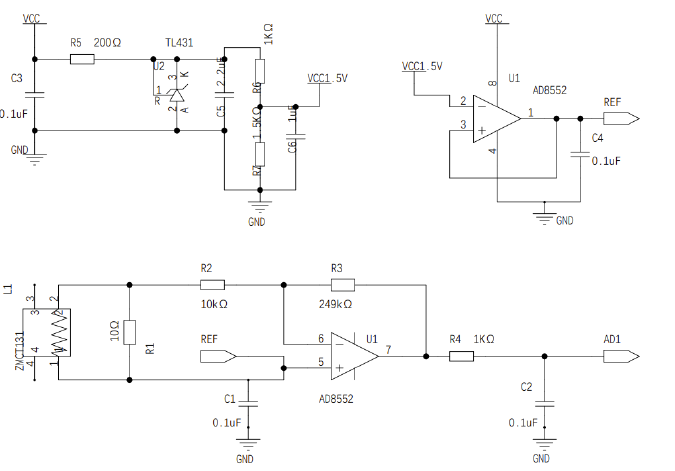
Figure 4. Current sampling and signal conditioning circuit based on the current